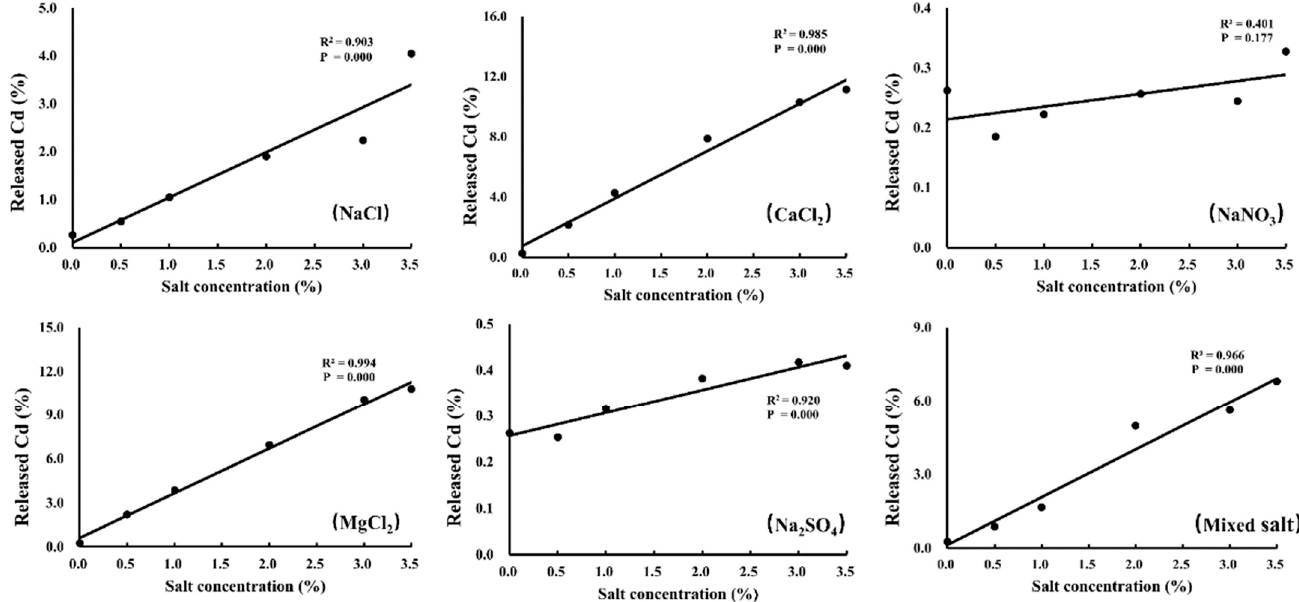
Figure 3. Correlations between Cd desorption rates and salt concentrations (each point is the average for all samples, R 2 is the coefficient of determination, P is the Pearson correlation coefficient).